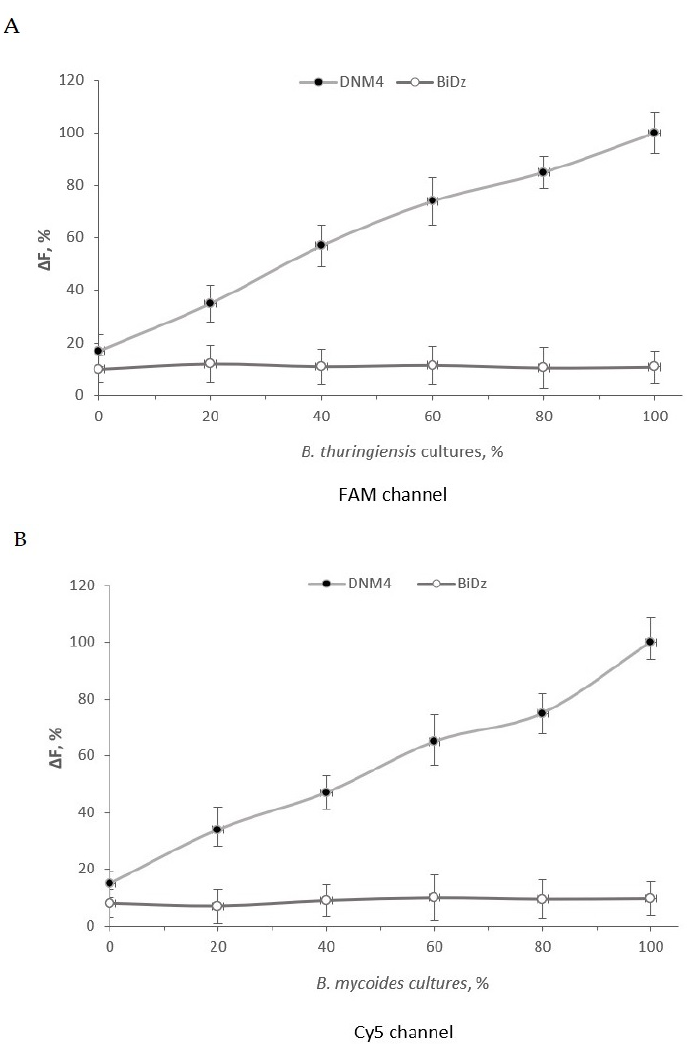
Figure 7. Unlike BiDz, DNM4 can detect specific bacteria in a mixture of cell lysates. ( A ) Normalized fluorescence intensity of either B. thuringiensis –specific BiDz (open circles) or DNM4 (filled circles) sensor in the presence of mixtures of B. thuringiensis cells containing a different amount of B. mycoides and B. cereus cells in the FAM channel after 1 h of incubation at 55 ◦ C. The fluorescence values were normalized by either the averaged fluorescence for all samples (for BiDz) or maximum fluorescence (for DNM4) achieved in the presence of 100% of B. thuringiensis cells (3 × 10 5 CFU). ( B ) Normalized fluorescence intensity of either B. mycoides –specific BiDz (open circles) or DNM4 (filled circles) sensor in the presence of mixtures of B. mycoides cells containing a different amount of B. thuringiensis and B. cereus cells in the Cy5 channel after 1 h of incubation at 55 ◦ C. The fluorescence values were normalized by either the averaged fluorescence for all samples (for BiDz) or maximum fluorescence (for DNM4) achieved in the presence of 100% of B. mycoides cells (3 × 10 5 CFU). Average values of three independent measurements are presented with one standard